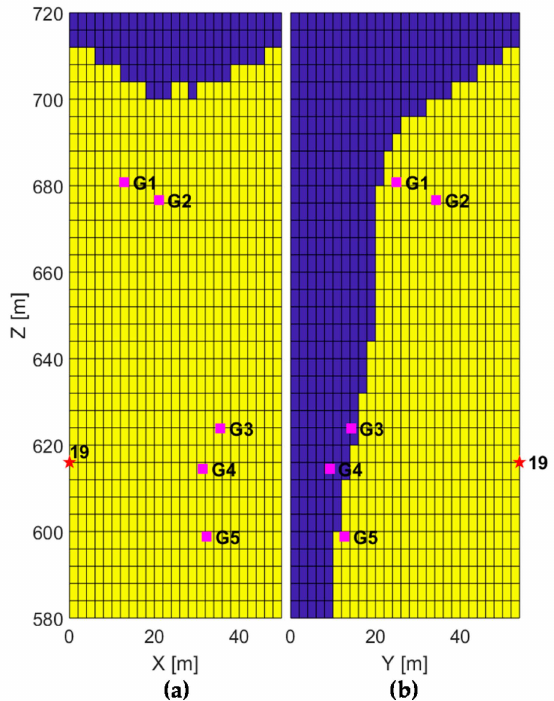
Figure 14. Location results for Fracture event 19 (Far event) presented on vertical slices in the front view ( a ) and side view ( b ). The blue area is the air, and the yellow area is rock mass. Pink squares indicate the five 3C geophones projected on the slice. Red stars indicate the event locations projected on the slice.